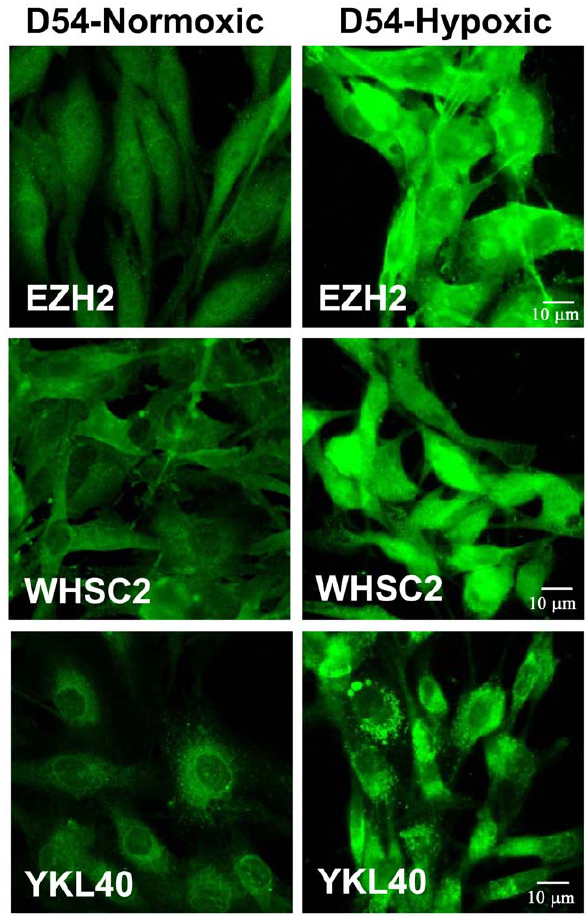
Figure 3. Immunofluorescent microscopy shows the up-regu- lated TAPP protein expression in the hypoxic D54 gliomas. D54 glioma cells were grown on a coverslips for 7 days either under normoxic or hypoxic conditions; the cells were fixed, permeabilized and stained with the primary antibodies (EZH2, Whsc2, and YKL-40). The cells were then visualized at 40 6 . The left column shows representative micrographs of normoxic cells, while the right column shows hypoxic